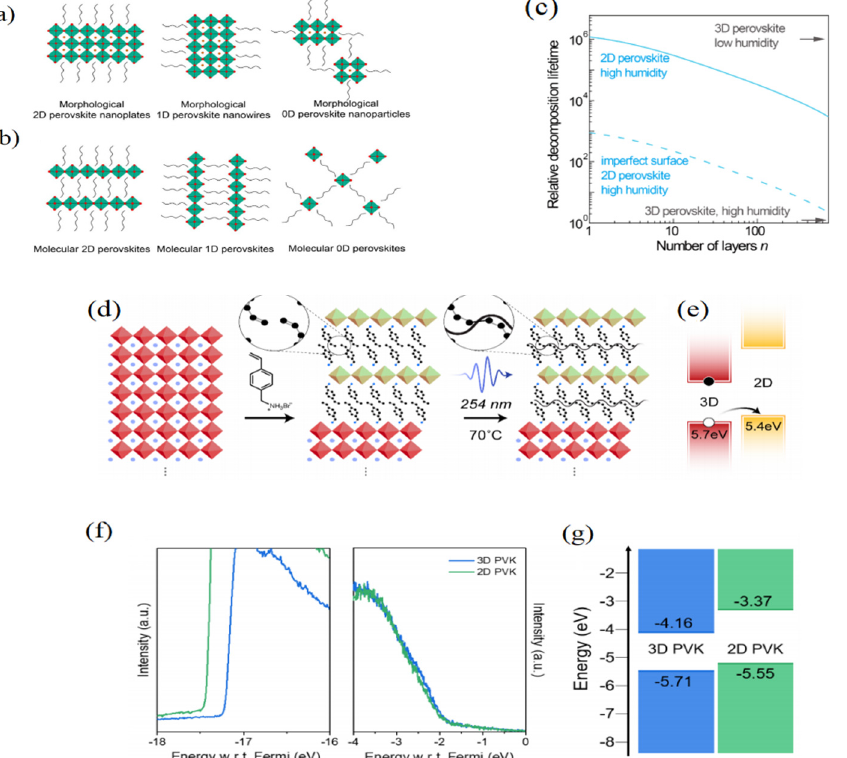
Figure 5. ( a ) The different morphological perovskites, and ( b ) different molecular perovskites. (Reprinted with permission from Ref. [59]. Copyright 2018 WILEY-VCH Verlag GmbH &Co. KGaA, Weinheim). ( c ) DFT simulation of the formation energy of 3D and 2D perovskite with different n val- ues. (Reprinted with permission from Ref. [67]. Copyright 2016 Royal Society of Chemistry). 2D/3D heterostructures have formation and optical properties by using the ligand VBABr. ( d ) Schematic dia- gram of processing which cross-linked 2D perovskites were formed by using the VBABr; ( e ) Energy level of the 2D/3D interface. (Reprinted with permission from Ref. [68]. Copyright 2019 ACS Publica- tion). ( f ) UP spectra of the 3D perovskite and the 2D perovskite. ( g ) Energy levels of the 3D and 2D perovskites. Reprinted with permission from Ref. [69]. Copyright 2021